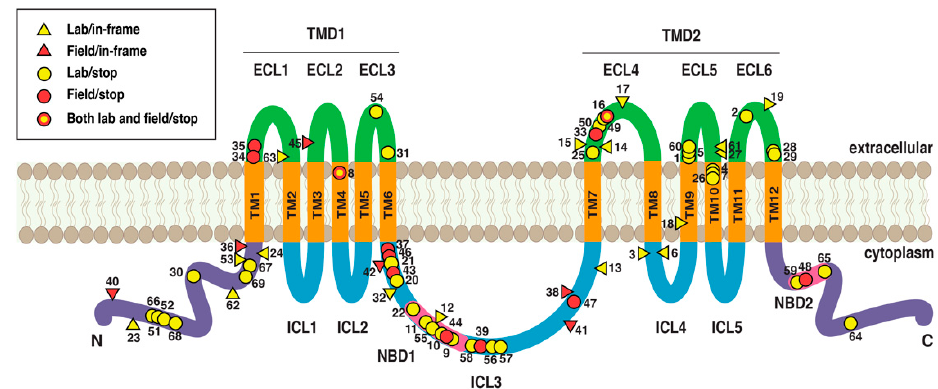
Figure 5. Sites affected in the PgABCA2 protein by 69 cDNA mutations associated with Cry2Ab resistance in 33 lab-selected pink bollworm from the U.S. and 8 field-selected pink bollworm from India (Table S2). The protein includes amino (N) and carboxyl (C) termini (purple), twelve trans- membrane domains (TM1–TM12, orange), six extracellular loops (ECL1–ECL6, green), and five intracellular loops (ICL1–ICL5, blue). The mutations shown introduce premature stop codons (circles) or are in-frame mutations (triangles) from field-selected individuals from India (red) or lab-selected individuals from the U.S. (yellow).